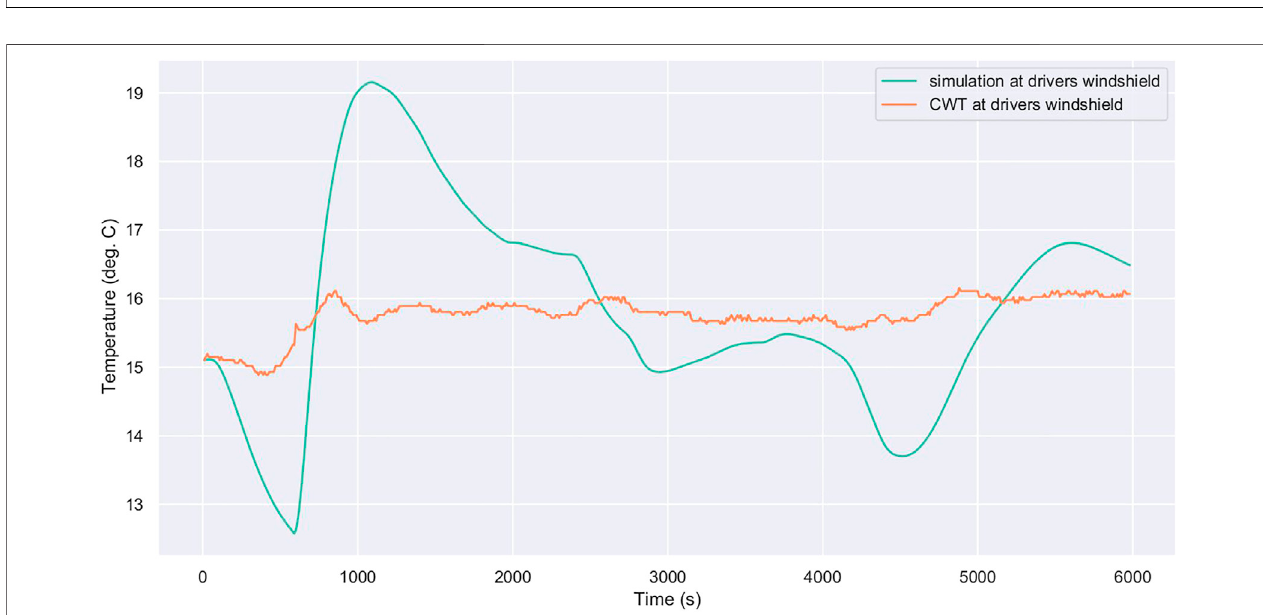
FIGURE 9 | Comparisonofmeasurement and simulated data for CWT3windshield temperature driver ’ s side. The trial settingsare 22 ° C withventsset todefrost/ fl oor with recirculated distribution and 140 g h − 1 of moisture at 100 km h − 1 for 30 min, then switching to fresh distribution for 30 min, before switching all settings off for 30 min.